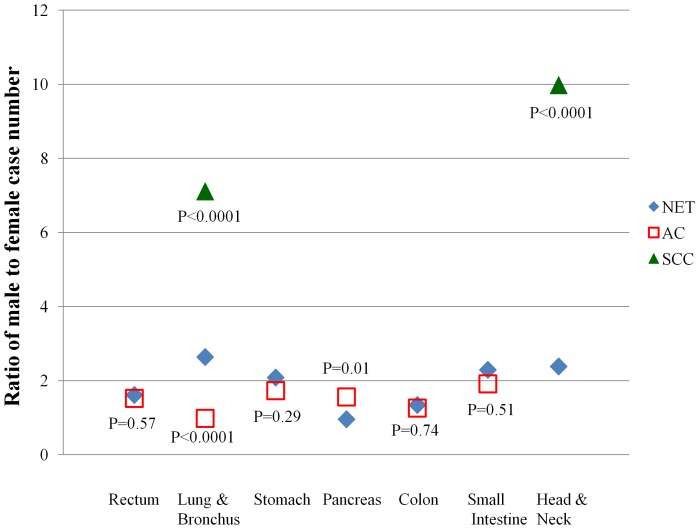
The comparison of male to female case number ratios by histologic subtypes in different primary sites, Taiwan.Abbreviations: AC = adenocarcinoma; NET = neuroendocrine tumor; SCC = squamous cell carcinoma. P-values were generated by chi-square tests to compare the distribution of sex between AC or SCC and NET.